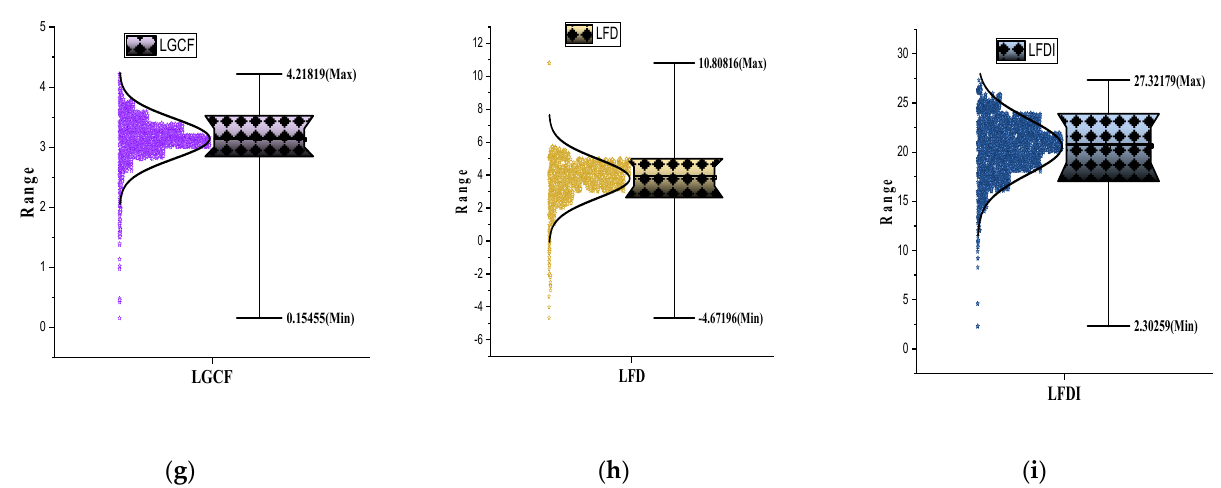
Figure 3. Box-plot statistics of the concerned variables such as ( a ) LCO2; ( b ) LFP; ( c ) LTGL; ( d ) LURP; ( e ) LTRD; ( f ) LLF; ( g ) LGCF; ( h ) LFD, and ( i ) LFDI.